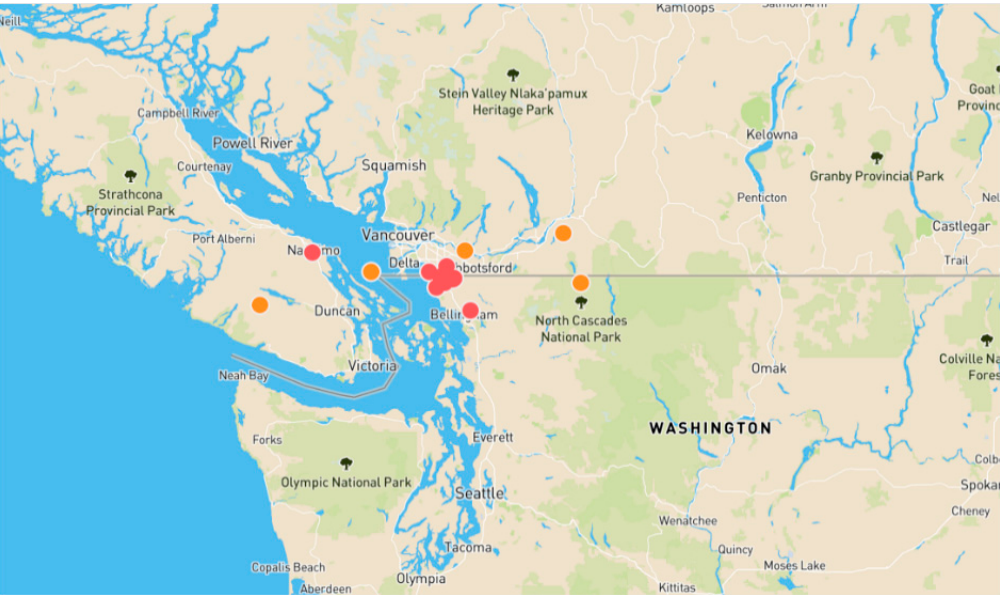
Figure 5. The results of grey prediction regarding Asian giant hornets’ spread range. Note: The red circle represents the distribution of Asian giant hornets in the data, and the orange circle represents the grey predicted distribution of Asian giant